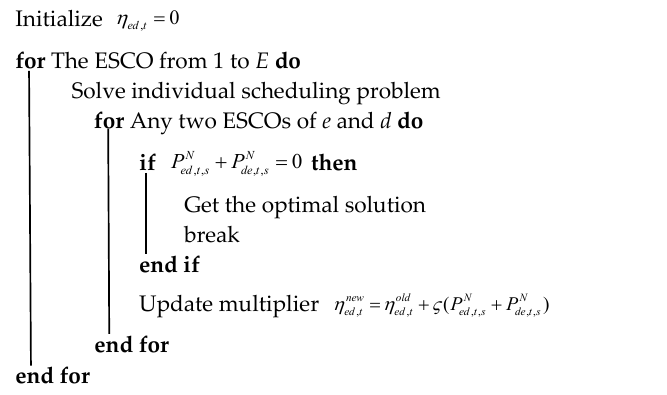
Algorithm 1: Lagrange Relaxation Algorithm.